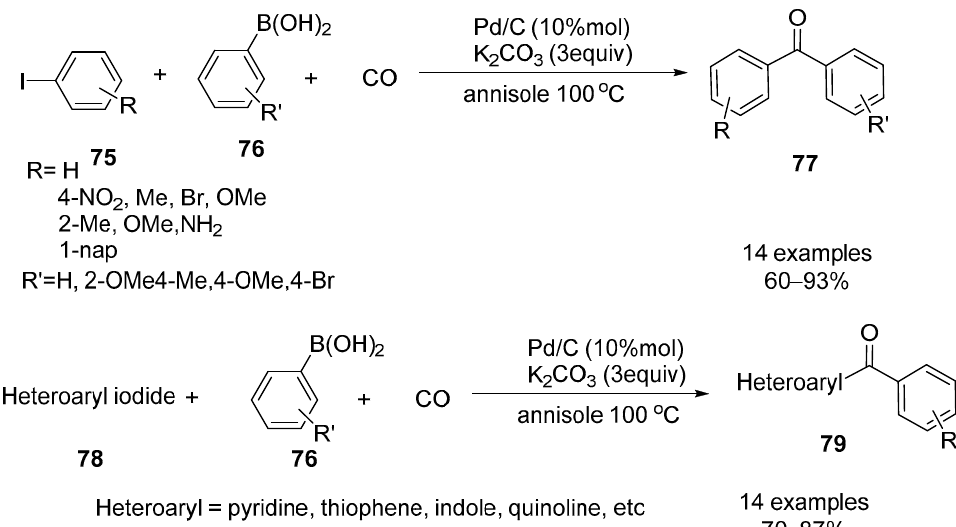
10 of 27 Table 3. Ligand-free versus XPhos-assisted Pd/C-catalyzed Suzuki–Miyuara cross-couplings of aryl chlorides [a] . R